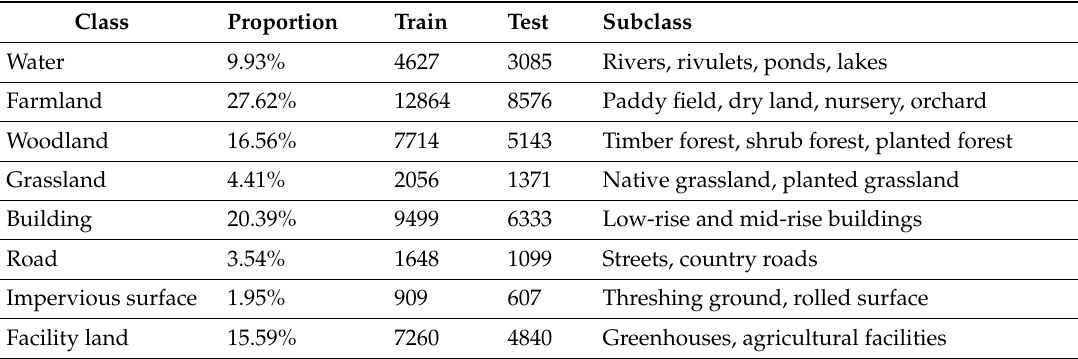
Table 4. Land-cover classes, sample numbers, and subclass descriptions in the Cixi dataset. Class